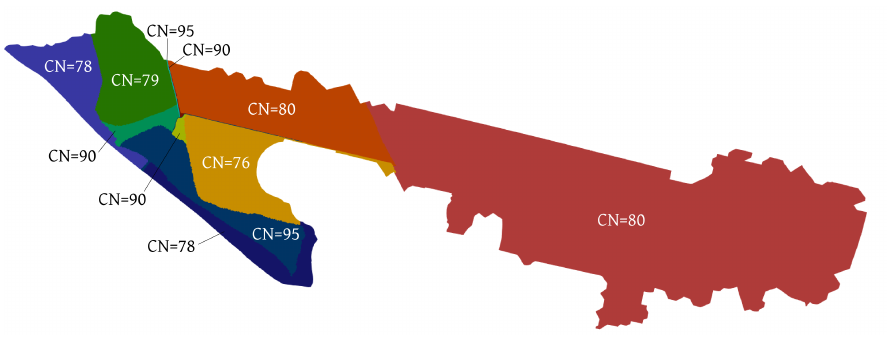
Figure 14. Case 3: SCS Curve Number values (CN). The bed level z of the overland domain and the initial water level for the lake and its upstream and downstream connections are shown in Figure 15. The spatial discretization is performed by means of an unstructured triangular and locally refined mesh of aproximately 600,000 elements. The mesh refinement is especially careful in the urban area, where the narrowness of the streets requires the use of small triangles in order to obtain an adequate representation (Figure